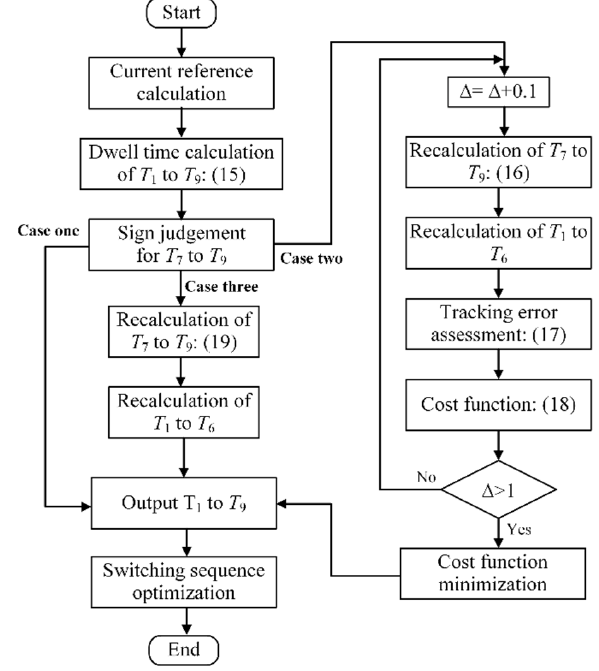
Figure 6. An overall diagram of the proposed modulation strategy.